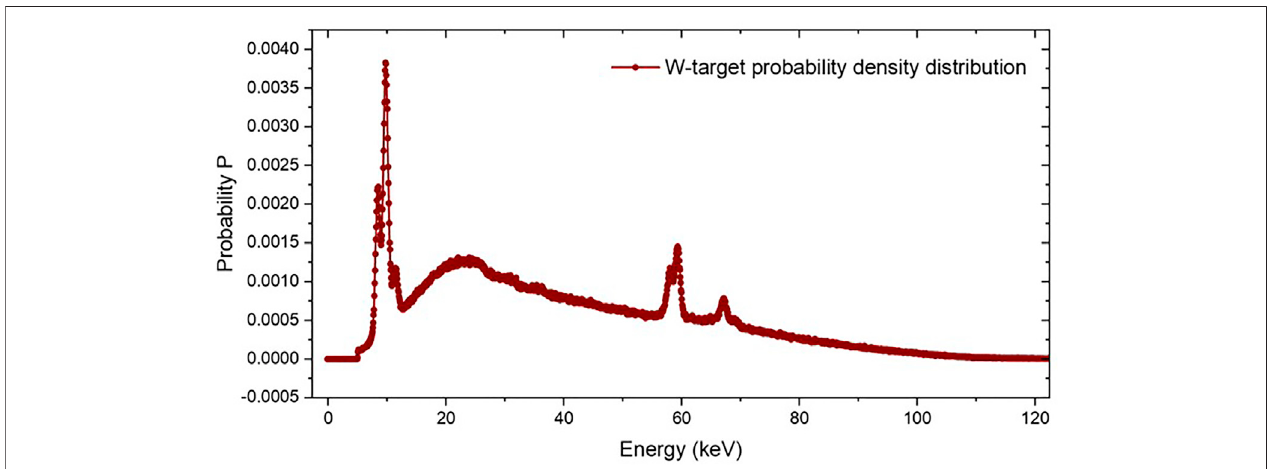
FIGURE 5 | Probability density distribution of the X-ray source. Probability density distribution converted from the primary spectrum of the X-ray source.